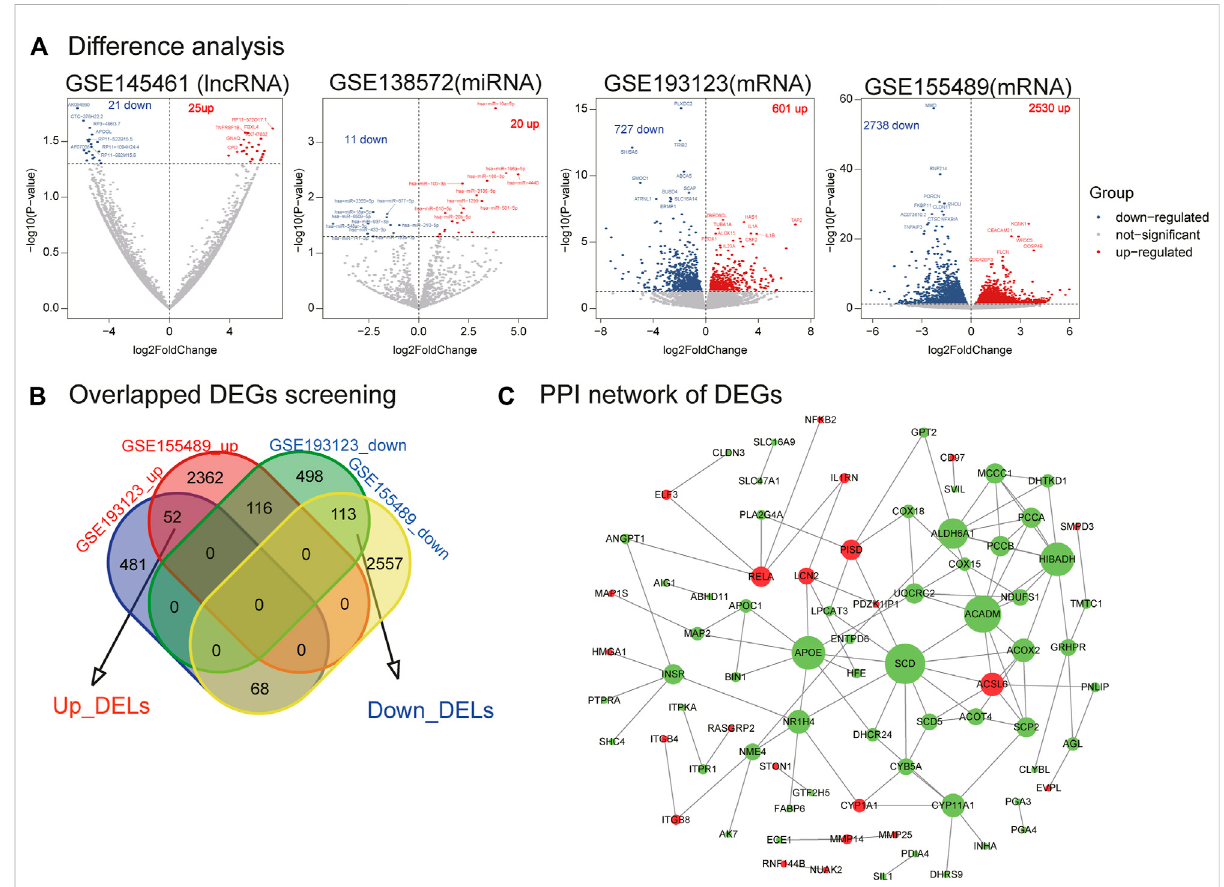
FIGURE 2 Differential analysisoflncRNA, miRNA,mRNA,mRNA crossovergenes,andPPI network analysis. (A) Differenceanalysis.Volplotof DELs,DEMs, and DEGs. (B) Overlapped DEGs screening. (C) PPI network of DEGs. Red nodes represent upregulated genes in PCOS, and green nodes represent downregulated genes in